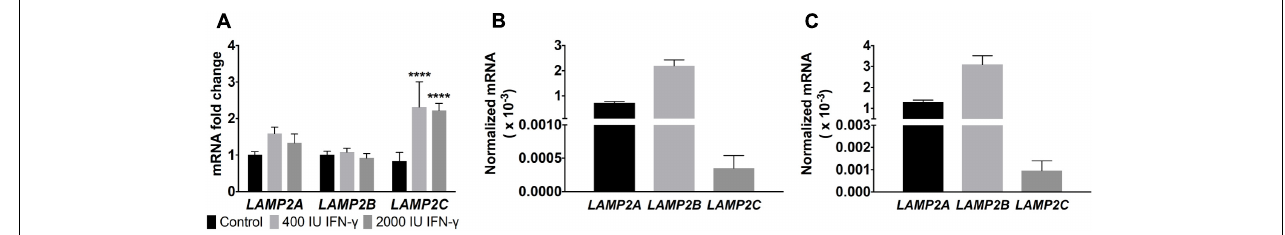
FIGURE 1 | LAMP2 expression in melanomas during IFN- γ treatment. (A) DM331 cells treated for 24 h with 400 or 2000 IU of IFN- γ . Gene expression of LAMP2A , LAMP2B , and LAMP2C were analyzed by qPCR. mRNA levels were normalized to ACTB expression with the expression of each isoform set equal to one for control cells without cytokine exposure. (B) Endogenous mRNA levels of LAMP2 isoforms in DM331 cells were quantitated relative to 18S mRNA levels. (C) Endogenous mRNA levels of LAMP2 isoforms in SLM2-Mel cells. Gene expression was quantitated relative to 18S mRNA levels. Data were analyzed by two-way ANOVA. ∗∗∗∗ p < 0.0001 ( n = 3).